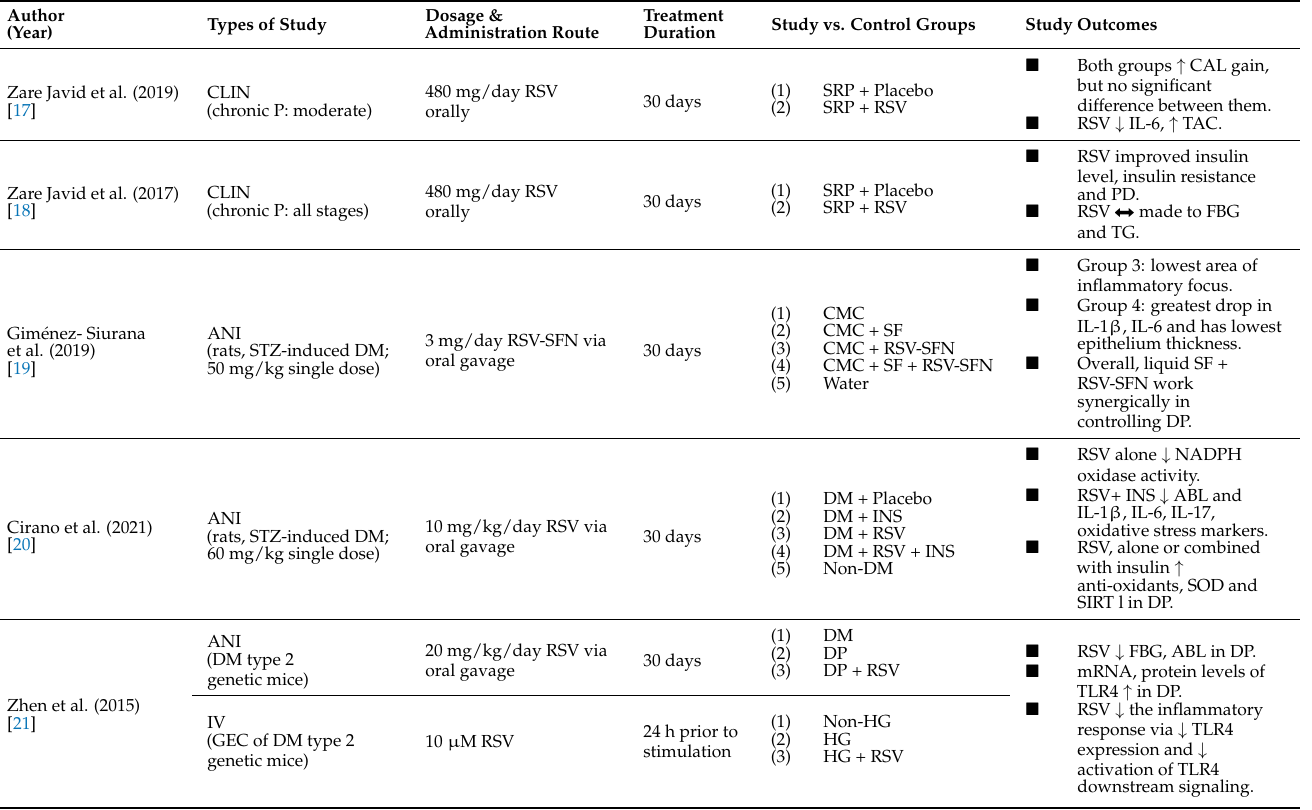
Table 2. Studies on the use of resveratrol (RSV) in diabetes-associated periodontitis (DP).